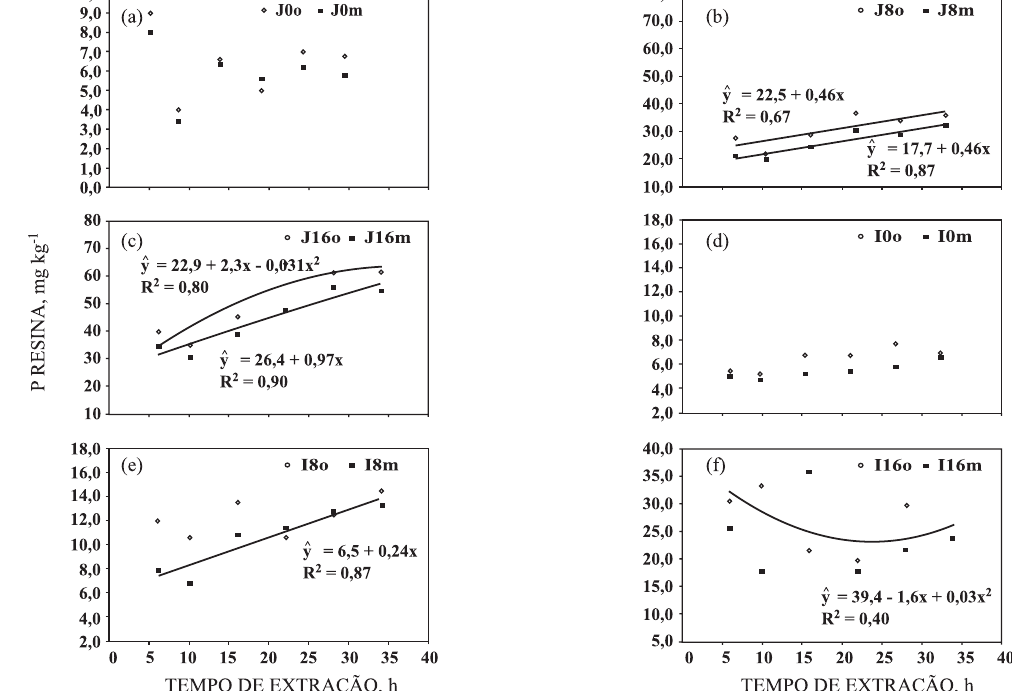
Figura 1. Extração pelo método RTA nos solos de Jaguariúna (a, b, c) e Itatinga (d, e, f), em função do tempo de extração e da dose de lodo aplicada ao